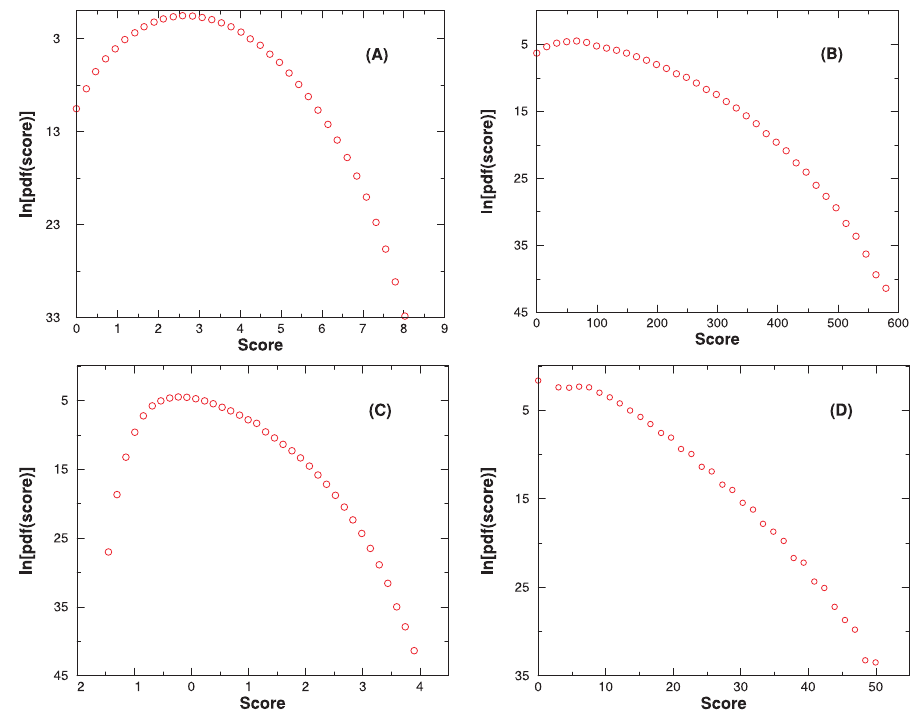
Figure 9. Example score PDF (normalized histogram) output by RAId_aPS. An MS 2 spectrum of parent ion mass 1640 : 80 Da is queried with default parameters, and the resulting score PDF for RAId, K-score, XCorr, and Hyperscore are shown respectively in panels A, B, C, and D. The number of APP within + 3Da of parent ion mass is about 10 19 .